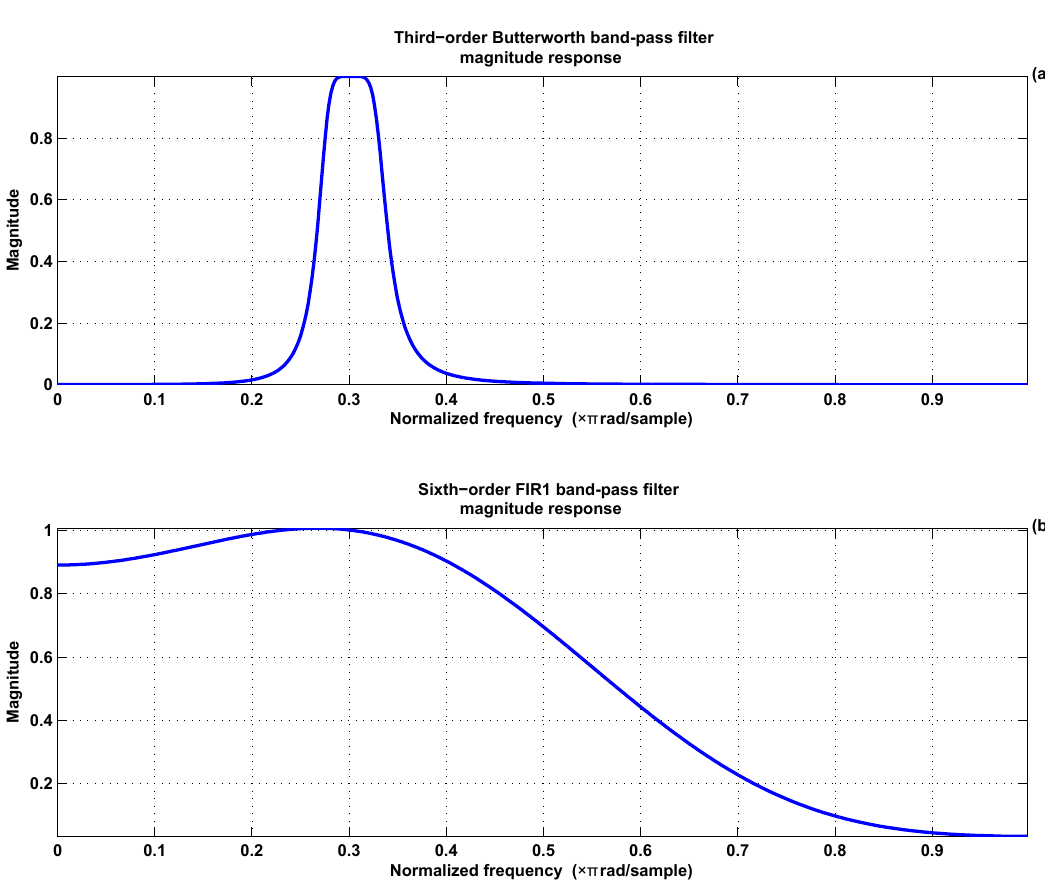
Figure 3. The filter responses of Butterworth (a) and FIR1 (b)